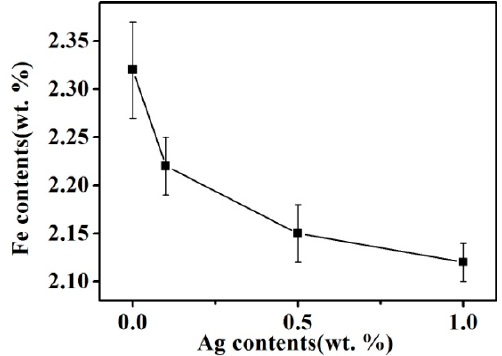
Figure 4. Fe content in Cu matrix of alloys solidified with the combined process.